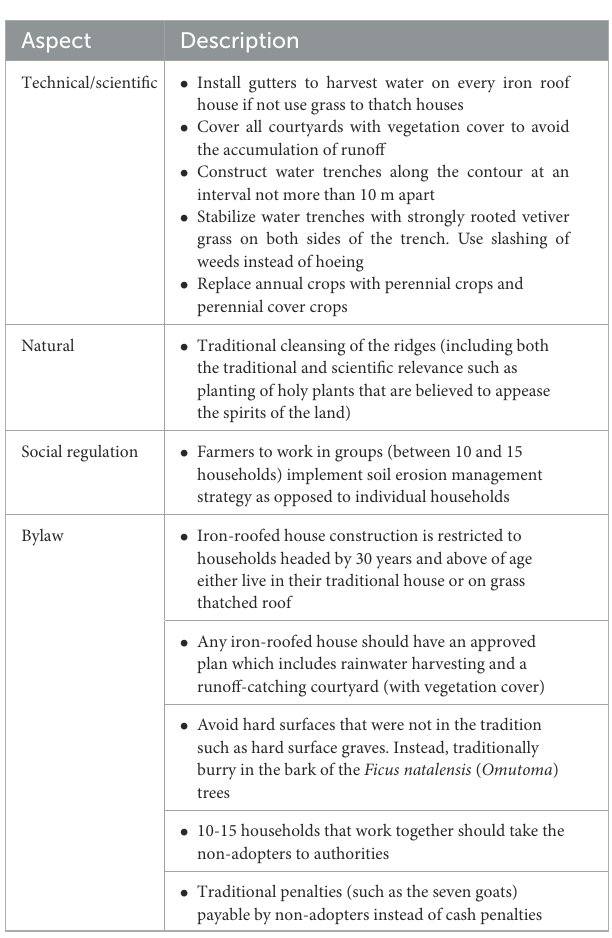
TABLE 3 Assemblage of a hybrid soil erosion control